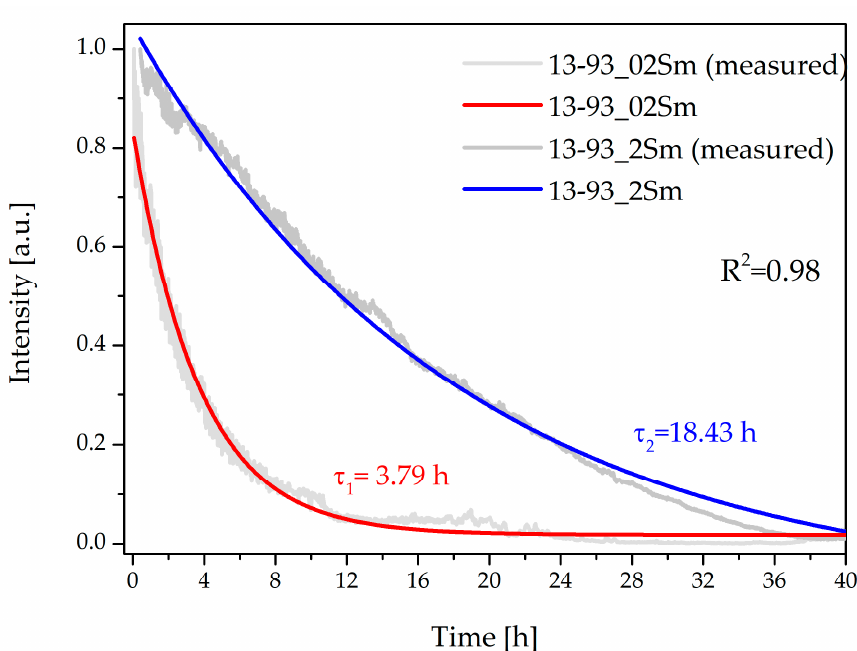
Figure 6. Characteristics of luminescence changes at 600 nm for 13-93 bioactive glass fibers doped with 0.2 and 2 %mol Sm 2 O 3 .